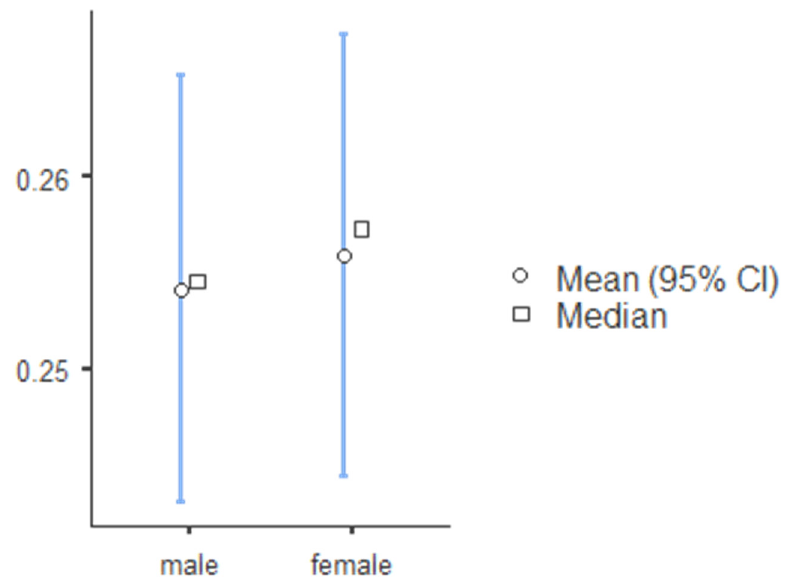
Figure 3. The descriptive chart of mean and median of permanent mandibular right canine index.